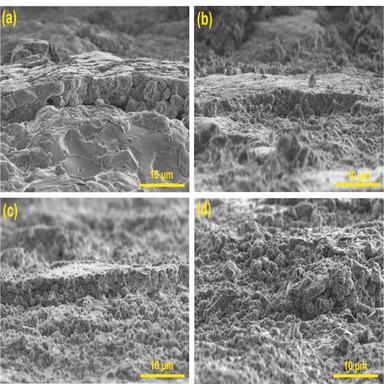
Section morphologies of the wear tracks of the Y–0BN (a), Y–5BN (b), Y–10BN (c), and Y–15BN (d) coatings under 0.7 m/s.